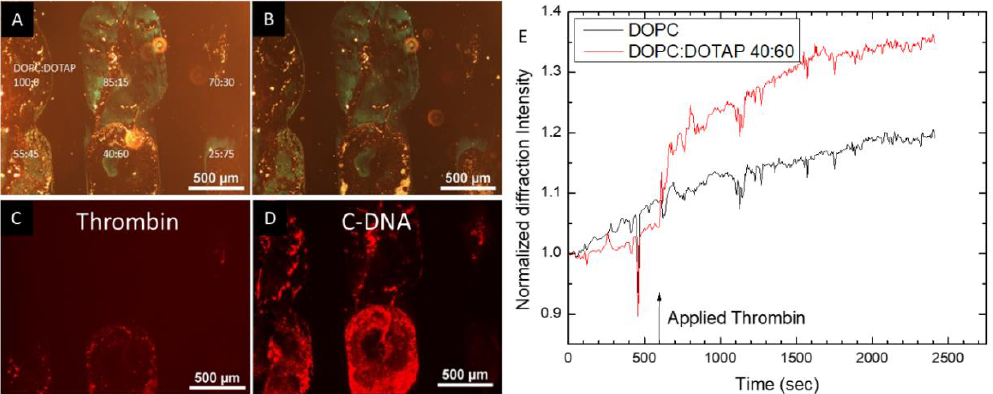
Figure 3. Lipid formulation was found to be critical to analyte binding to the gratings and detection by the monitoring of diffraction. ( A ) diffraction image of an array of spots of varying DOPC:DOTAP ratios. ( B ) diffraction image of the sample in A after exposure to fluorescently labeled thrombin. ( C ) Fluorescence micrograph of the sample after exposure to fluorescently labeled thrombin. ( D ) Fluorescence micrograph of the sample in ( C ) after exposure to fluorescently labeled cDNA for the aptamer sequence. ( E ) Sensorgram showing the optical response of the gratings upon exposure to analyte. There is a signal detected in the DOPC:DOTAP 40:60 gratings, but not in the DOPC control. Additionally, the lipids consisting of mixtures of DOTAP and DOPC were used to test the possibility of false positive signals caused by non-specific binding. For instance, since DOTAP should